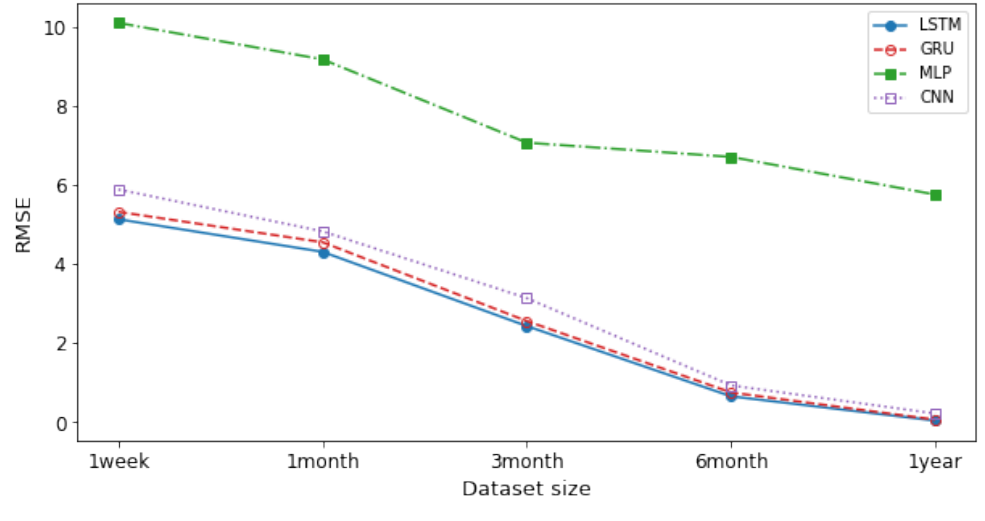
Figure 9. RMSE for different dataset size.